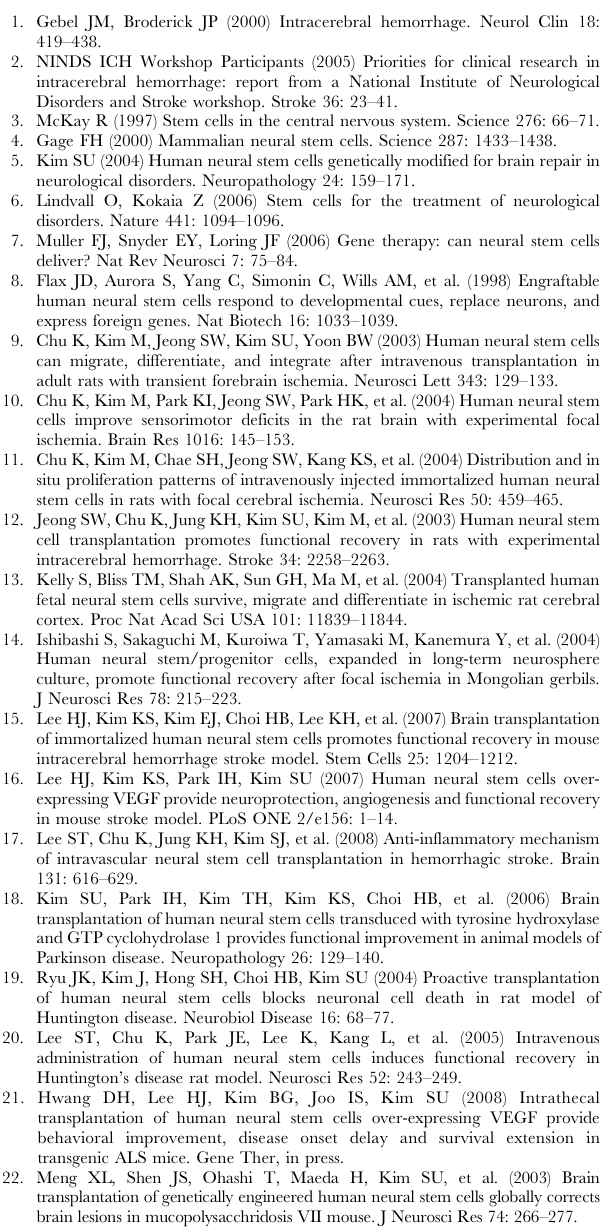
Figure S2 A: Hematoxylin and Eosin-stained section of mouse brain transplanted with F3.Akt1 NSCs. Six months post- transplantation. Transplantation of v-myc-immortalized F3 or F3.Akt1 human NSCs did not cause tumor formation in the brain. B: Inset indicates higher magnification of the marked area. Figure S3 A: A schematic drawing of the ICH brain in which b - gal-labeled human NSCs were transplanted. Two days